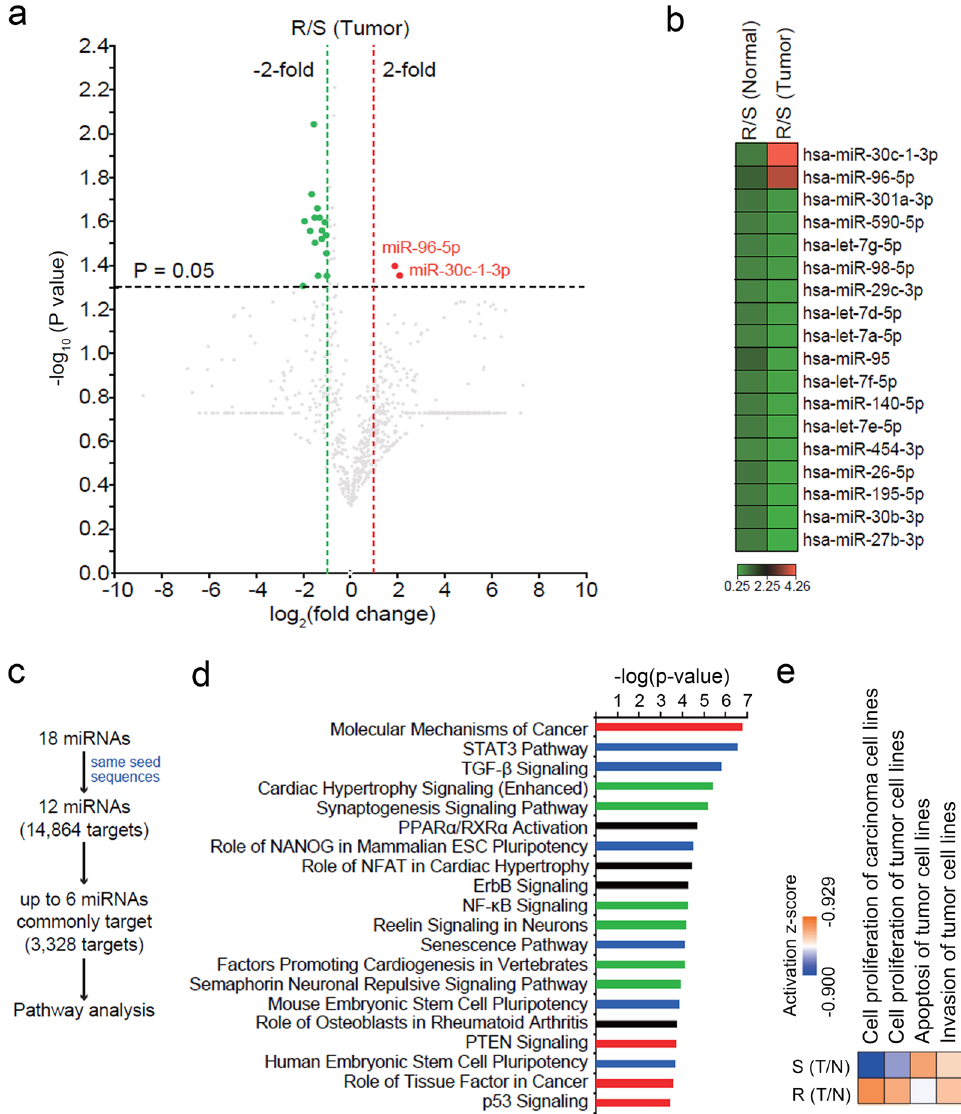
Figure 1. Upregulation of miR-96-5p in tumors from sunitinib-resistant clear cell renal cell carcinoma (CCRCC) patients. ( a ) Volcano plot of differentially expressed miRNAs from microarray of sunitinib-resistant and sunitinib-sensitive CCRCC patients. ( b ) Heatmap of 18 miRNAs differentially expressed in resistant samples compared with sensitive samples in tumors. ( c ) Schematics of target prediction and pathway analysis with differentially expressed miRNAs presented in (a) and (b). ( d ) Predicted common targets of differentially expressed miRNAs were subjected to Ingenuity Pathway Analysis (IPA), and the top 20 enriched canonical pathways are shown (red bars: pathways directly correlated with cancer; blue bars: pathways of organismal growth and development; green bars: pathways of cellular growth, proliferation, and development). ( e ) A heatmap of the cellular and biofunctions enriched in resistant samples compared with sensitive samples. Orange (positive z-score) or blue (negative z-score) color codes represent the activation or inhibition of the given cellular